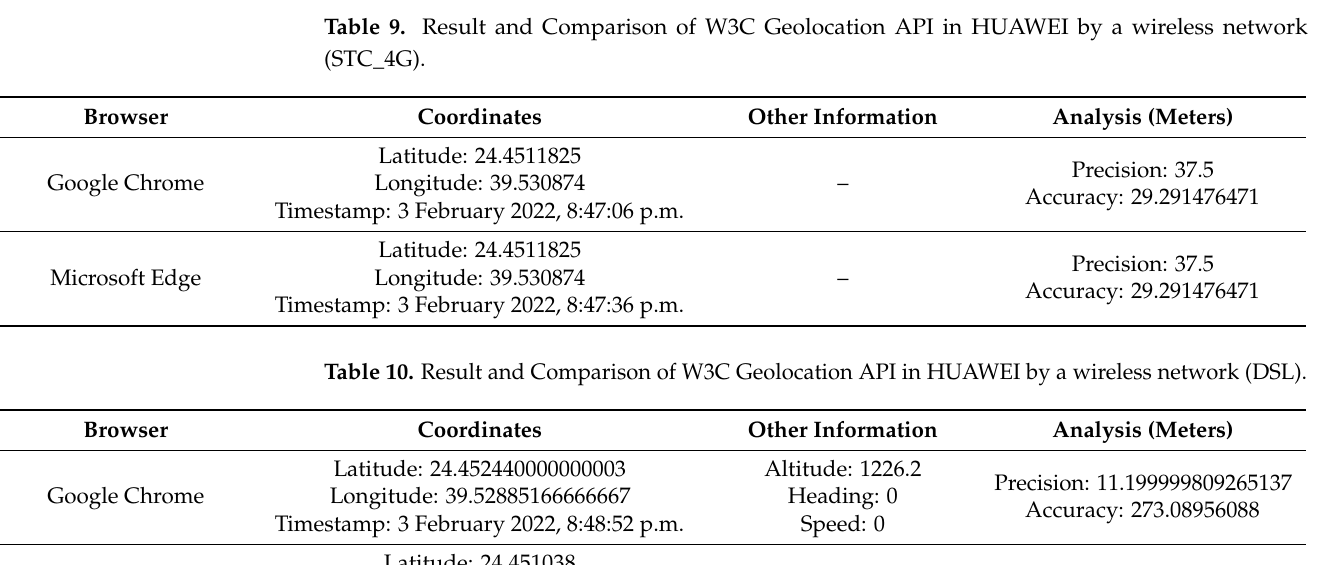
Table 9. Result and Comparison of W3C Geolocation API in HUAWEI by a wireless network